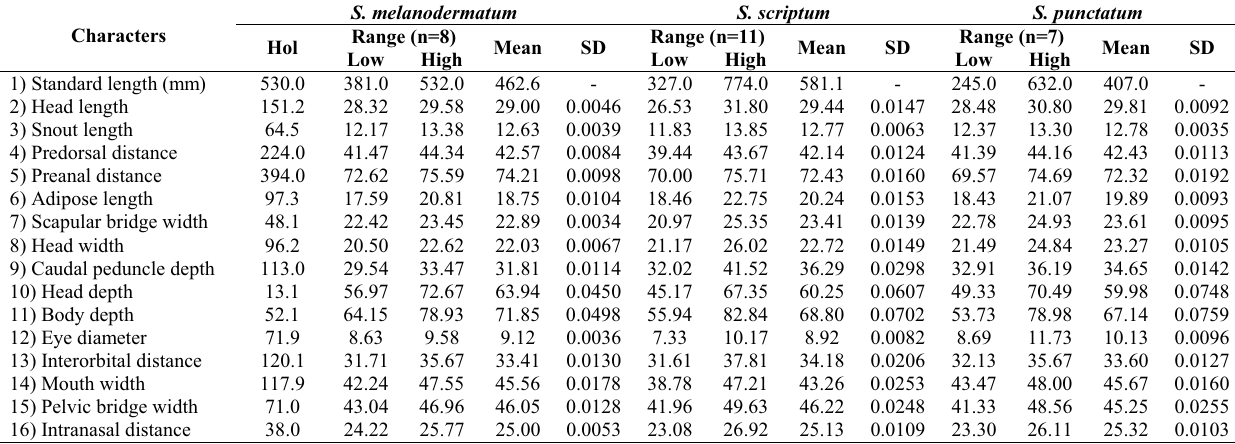
Table 2. Morphometrics of S. melanodermatum , S. scriptum and S. punctatum expressed as percent of SL (2–8) and HL (9–16). Hol =